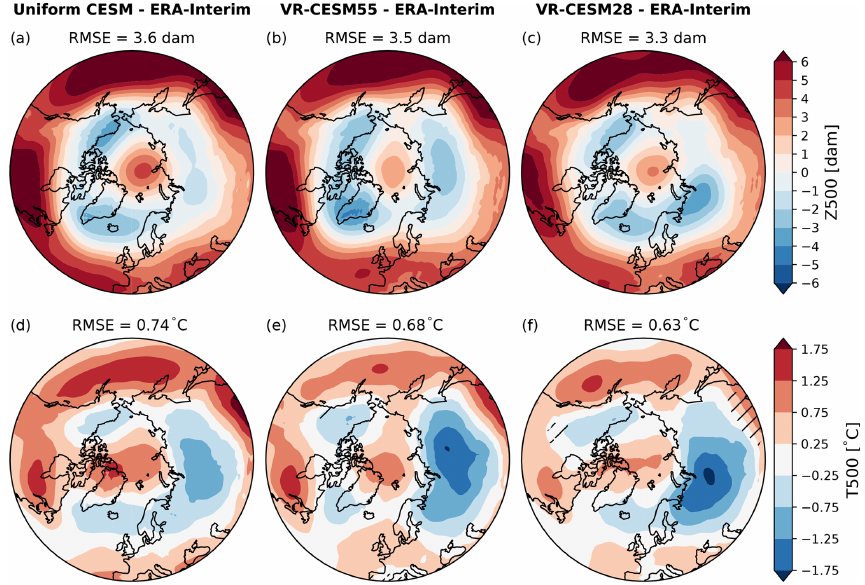
Figure 3. Mean summer (JJA) anomalies of 500hPa geopotential height (Z500, a – c ) and air temperature (T500, d – f ) with respect to ERA- Interim over the period 1980–1999. Shown is 55–90 ◦ N, the same region over which the area-weighted RMSE was calculated that is listed above each panel. Hatching in panel (f) indicates that the VR-CESM simulation is significantly different ( p < 0 . 05) from Uniform CESM. No significance was found in (b) , (c) , and (e) . Prior to subtraction, all data have been regridded to a common regular mesh of 1 ◦ using bilinear interpolation.